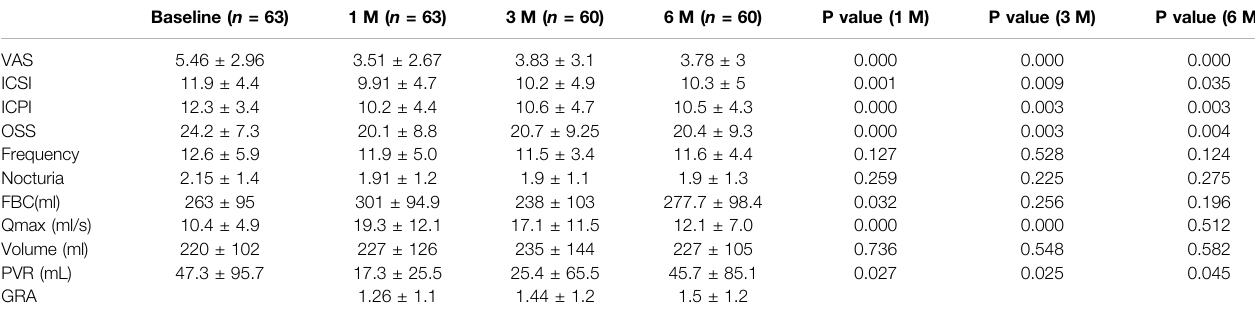
TABLE 1 | Changes in measured parameters from baseline to 1 and 3 months in patients treated with a single PRP injection. Baseline ( n = 63) 1 M ( n = 63) 3 M ( n = 60) 6 M ( n =